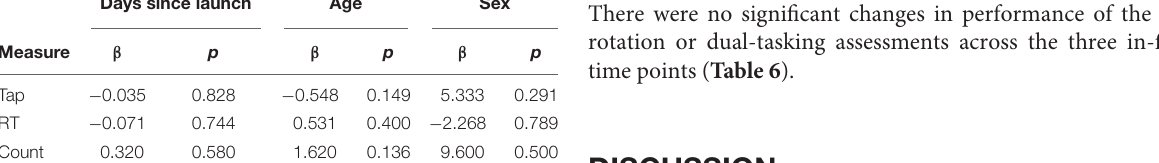
TABLE 5 | Direct effects of the microgravity environment. Days since launch